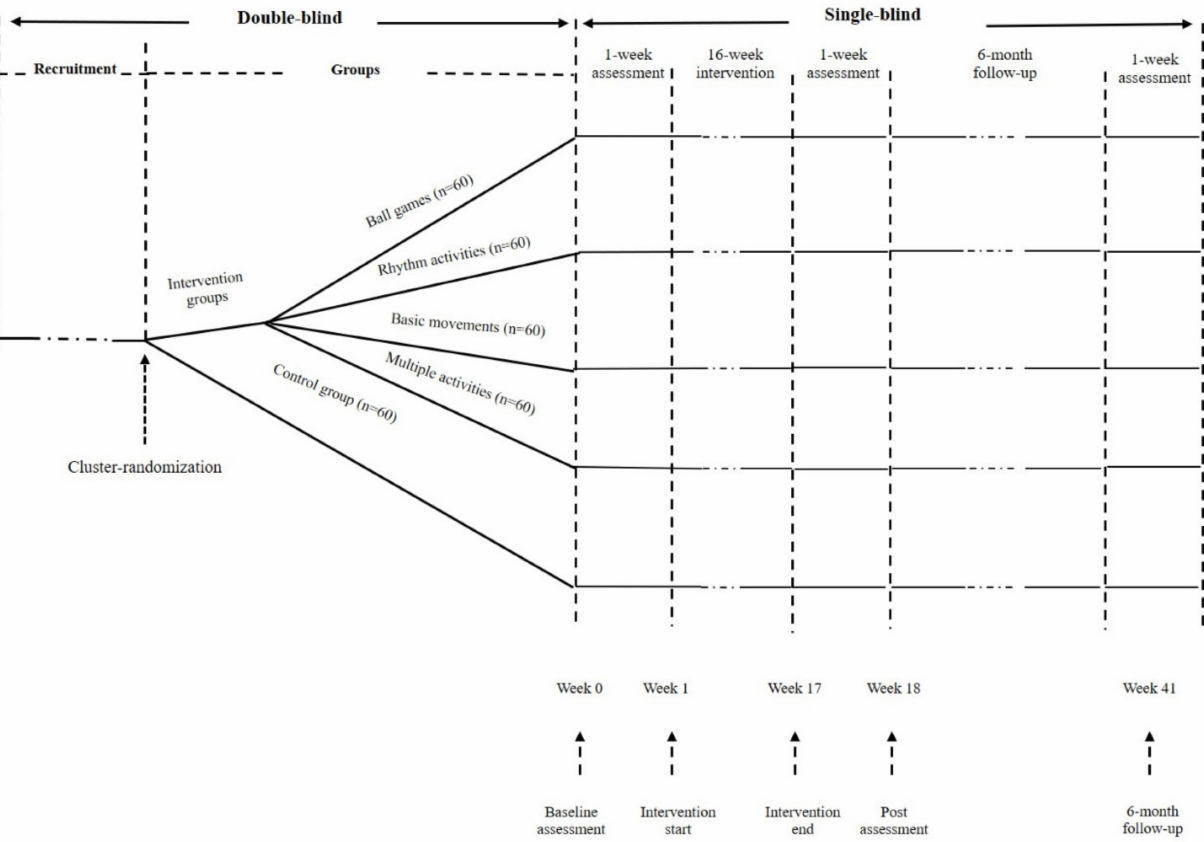
Figure 1. Design of the PEFP